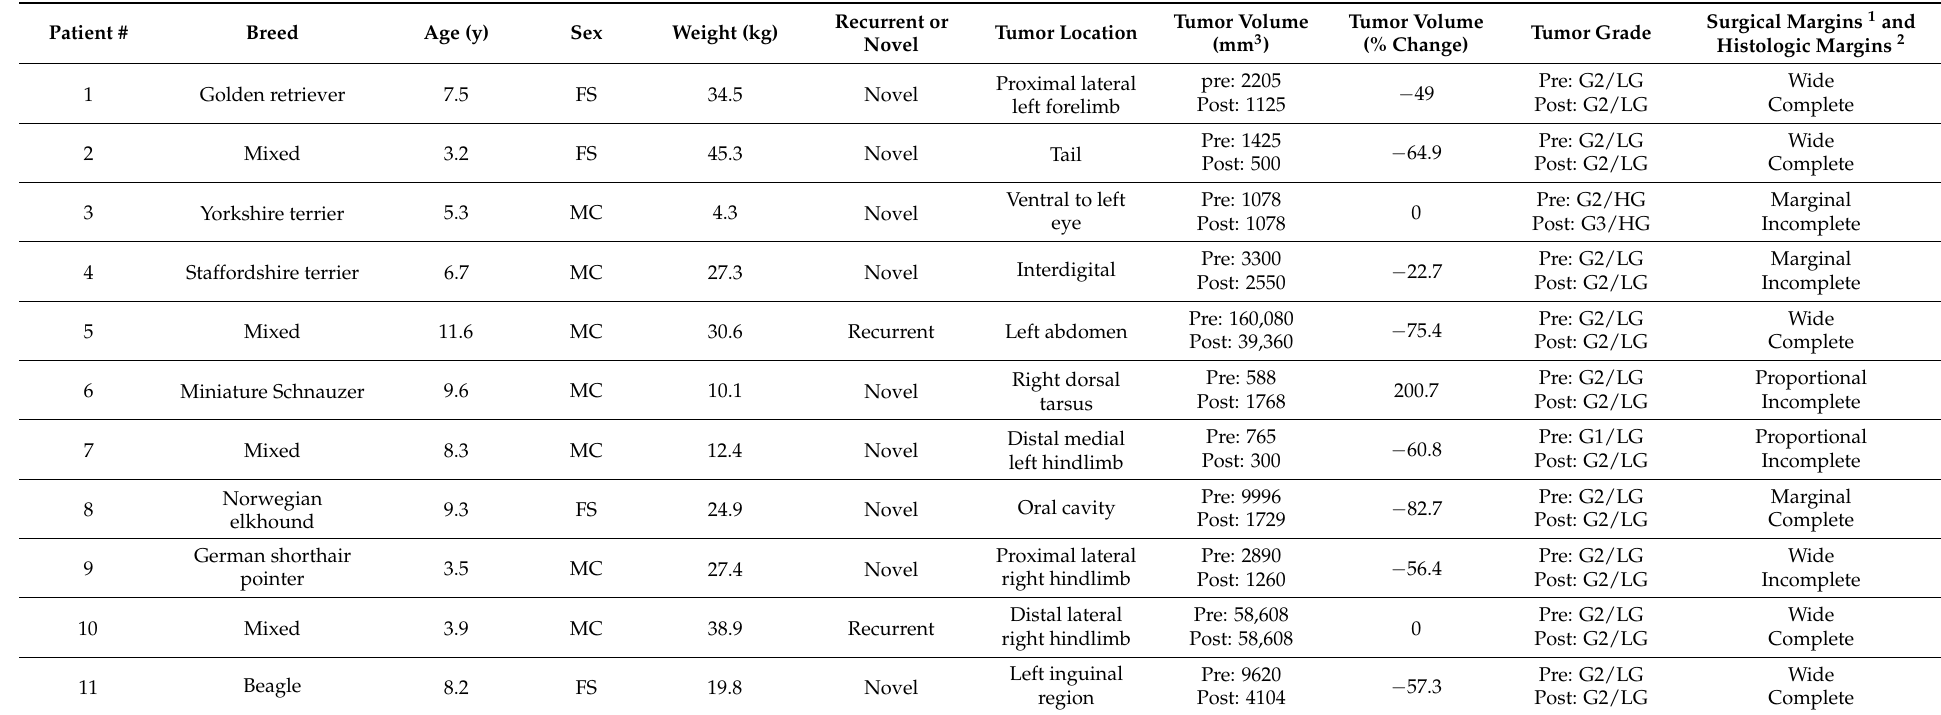
Table 1. Patient demographics and tumor